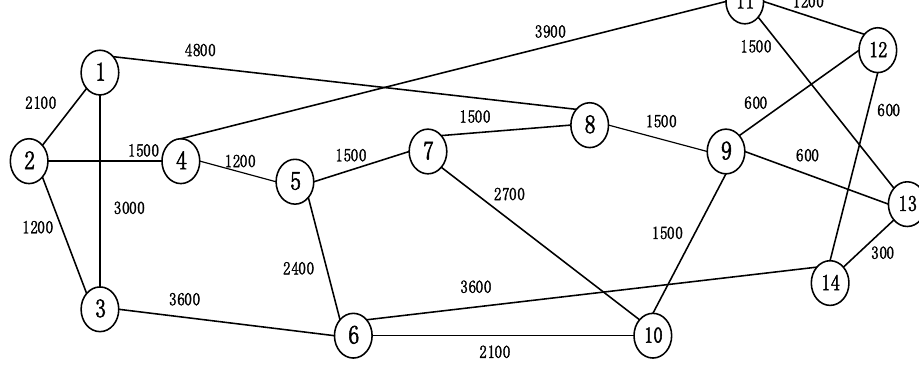
Figure 2. National science foundation network (NSFNET) topology. Table 3. Parameter settings in simulations.